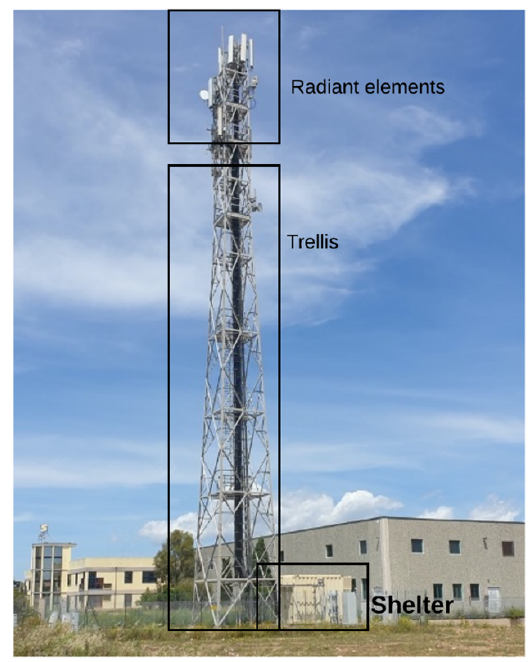
Figure 1. Components of the antenna